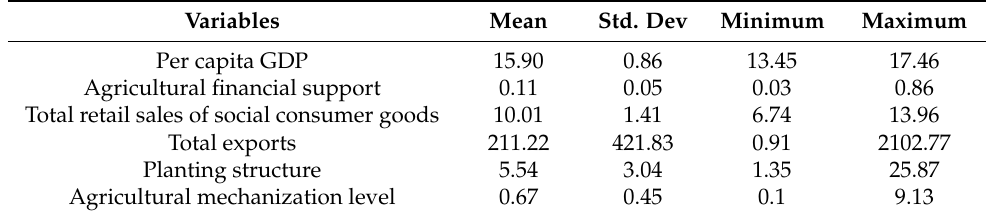
Table 2. Descriptive statistics of driving factors